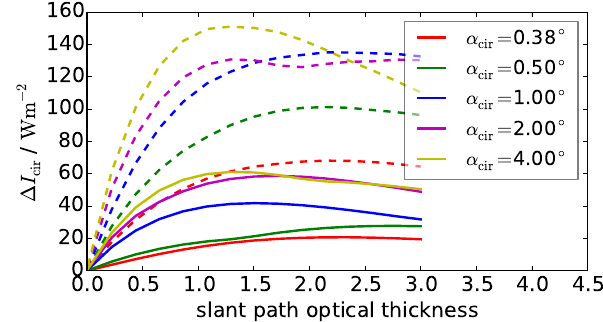
Fig. 3. Uncertainty in circumsolar irradiance for certain fields of view (legend gives opening half-angle in degrees). Solid lines: for r eff = 25 µm and undefined ice particle shape. Dashed lines: for un- defined r eff and ice particle shape.